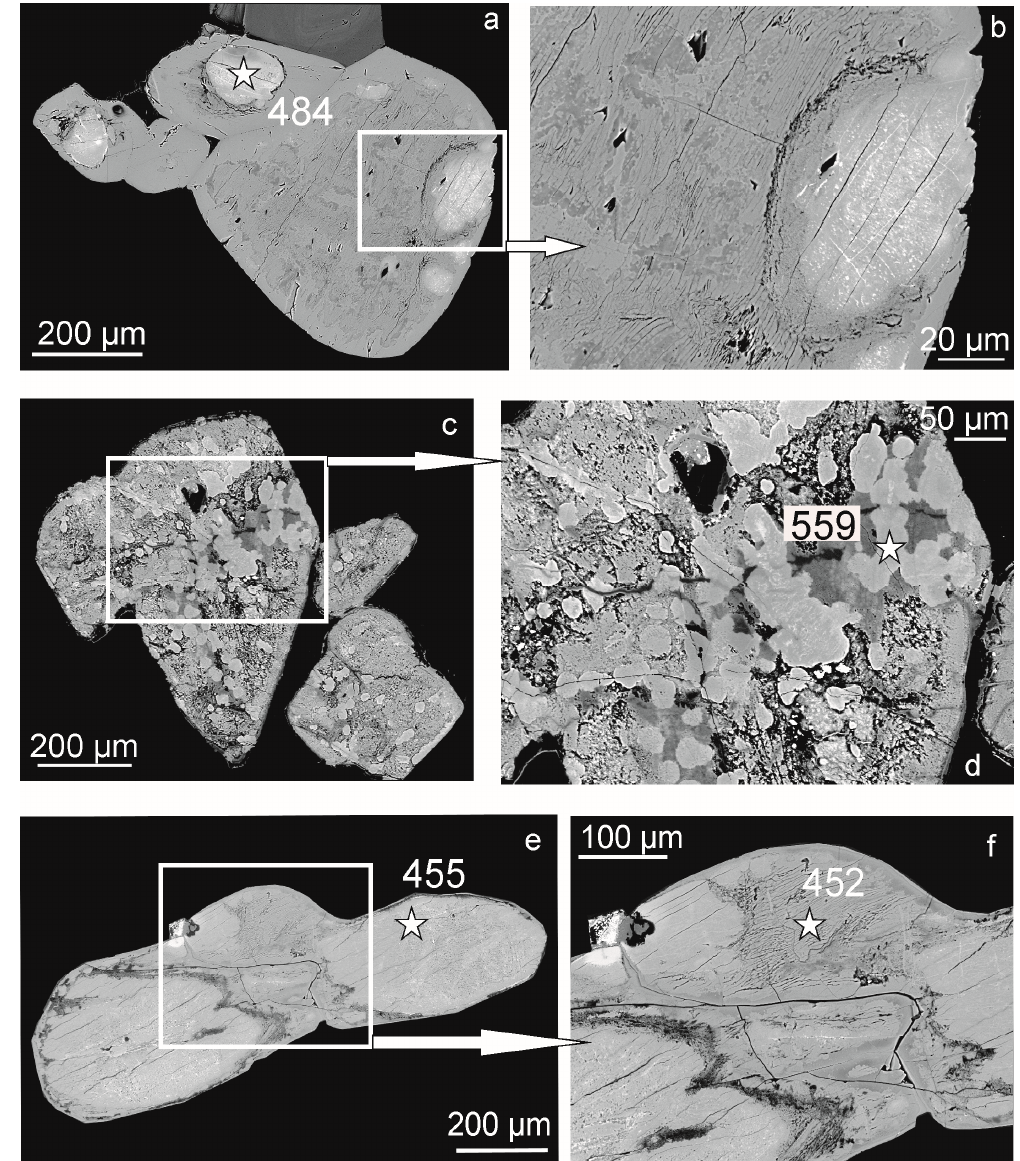
Figure 2. Morphology of titanosilicates from the nepheline syenite pegmatite, Sakharjok massif, Kola Peninsula. SEM, BSE images. Arrows to the right indicate enlarged images of the respective squared areas. Asterisks indicate point of microprobe analyses, analyses numbers correspond to Table 2. ( a , b )—“eye-like” (an. 484), ( c , d )—homogenous” (an. 559), ( e )—“porous” (an. 455), and ( f )—“layered” (an. 452), titanosilicates. Table 2. Chemical compositions (wt %) and formula coefficients (apfu) for different morphological groups of titanosilicates presented in Figures 1 and 2. Variations correspond to 79 analyses of the rinkite group minerals from the nepheline syenite pegmatite, Sakharjok massif, Kola Peninsula. An. No.*